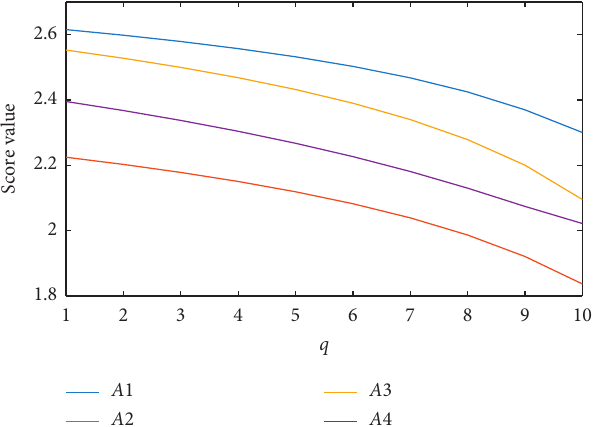
Figure 8: Scores of A ( i � 1 , 2 , 3 , 4 ) when p � 1 and q ∈ [ 0 , 10 ]( θ � 2 ) i